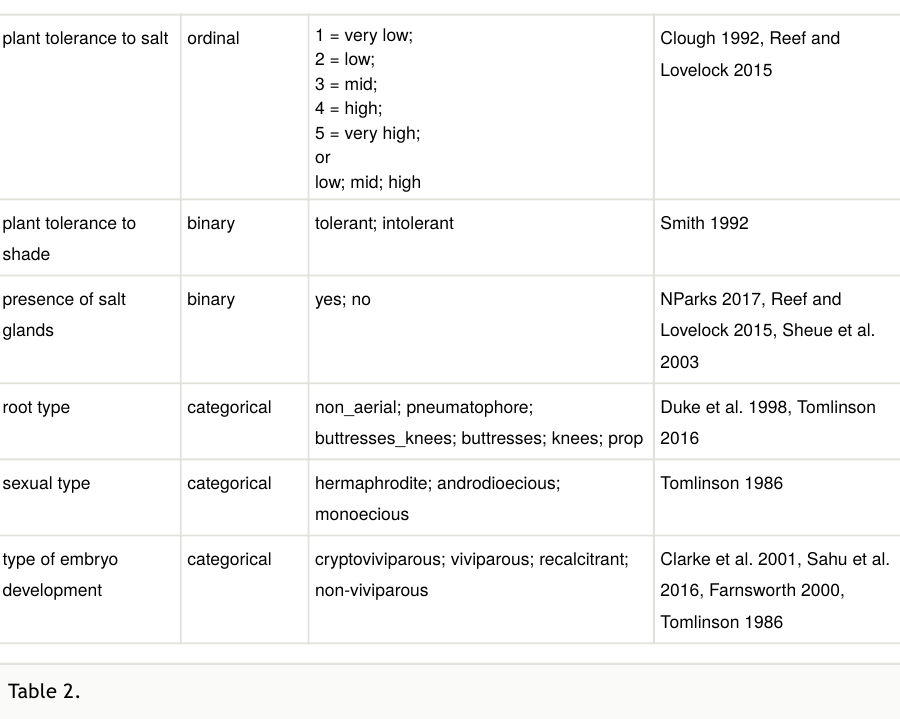
List of quantitative traits available in the dataset and respective references of trait